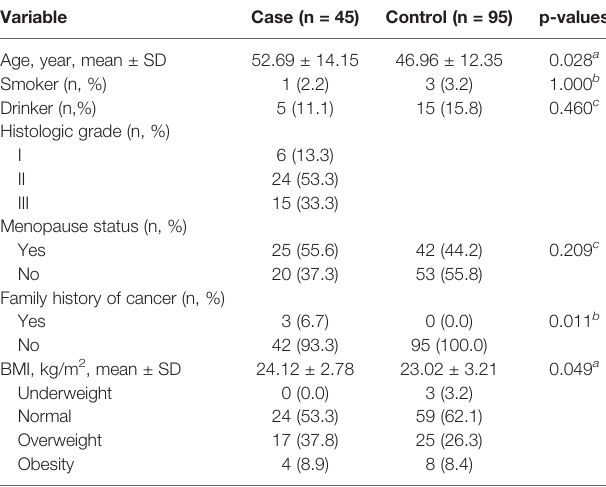
TABLE 1 | Demographic and clinical characteristics of recruited participants.